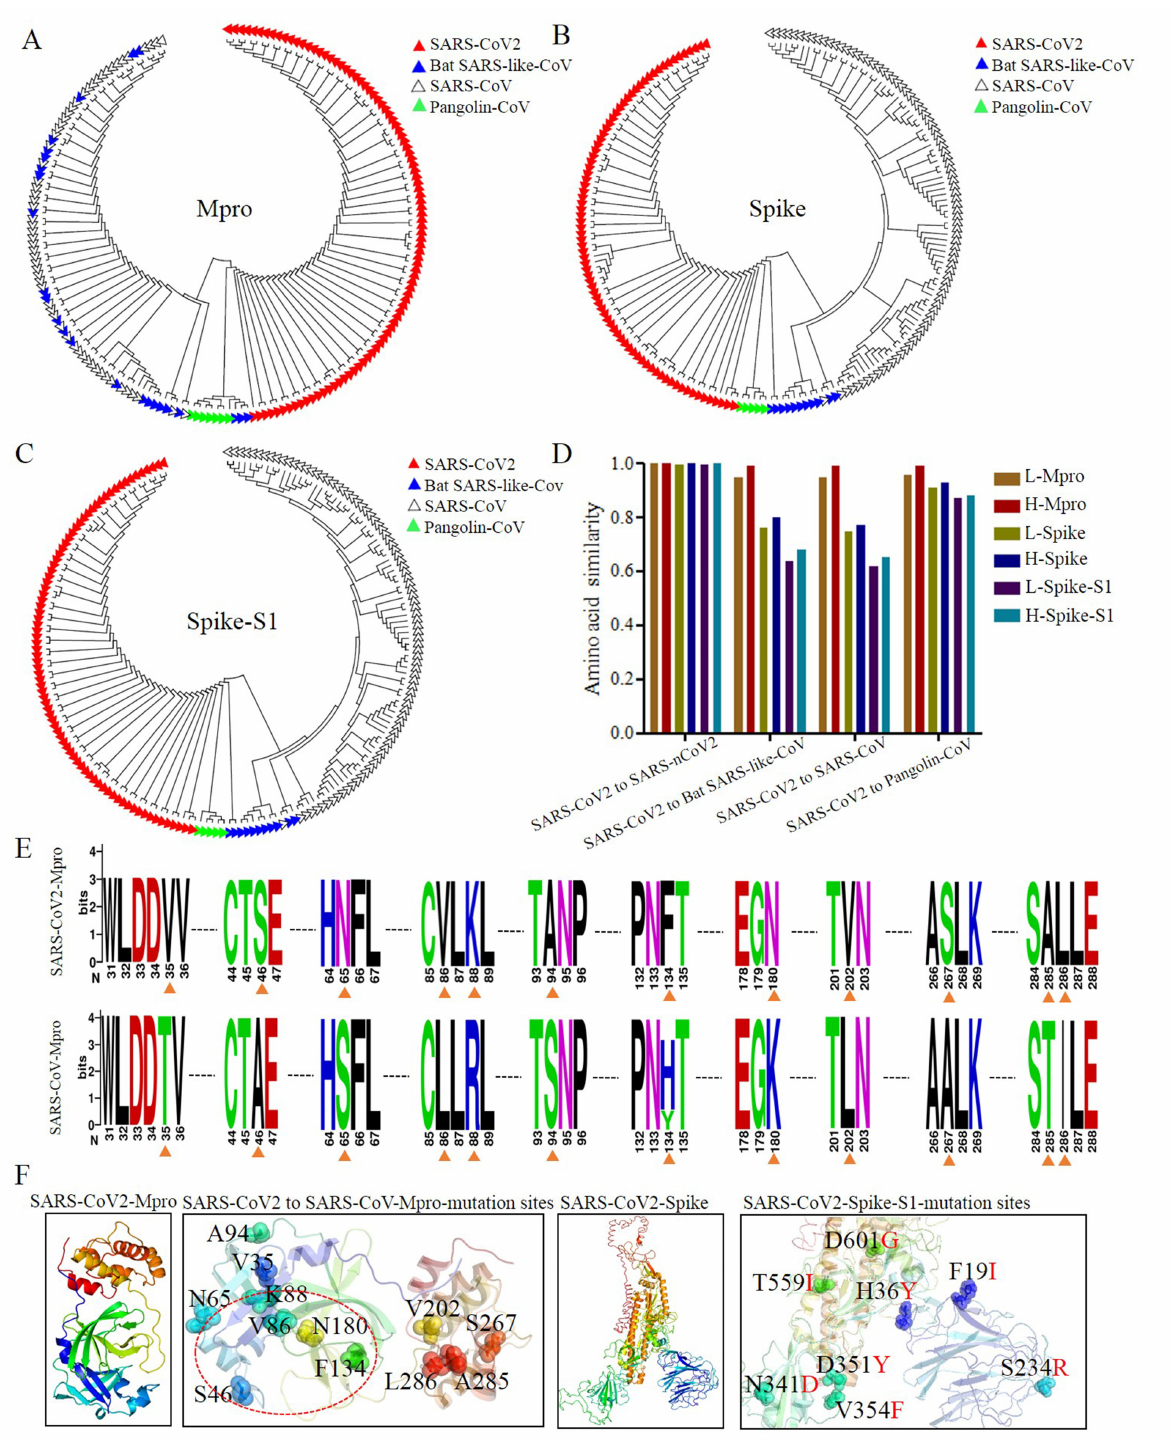
Figure 1. The evolution and conservation for Mpro and Spike of SARS-CoV-2. (A), (B) and (C) represent phylogenetic trees of Mpro, Spike, and Spike RBD. (D) Amino acid sequence similarity among SARS-CoV-2, bat SARS-like-CoV, and SARS-CoV. L- and H- represent the lowest and highest sequence similarity between sequences in two types of coronavirus, respectively. (E) Sequence logo of Mpro for SARS-CoV-2 and SARS-CoV. (F) Differential conserved amino acids of Mpro/Spike between SARS-CoV-2 and